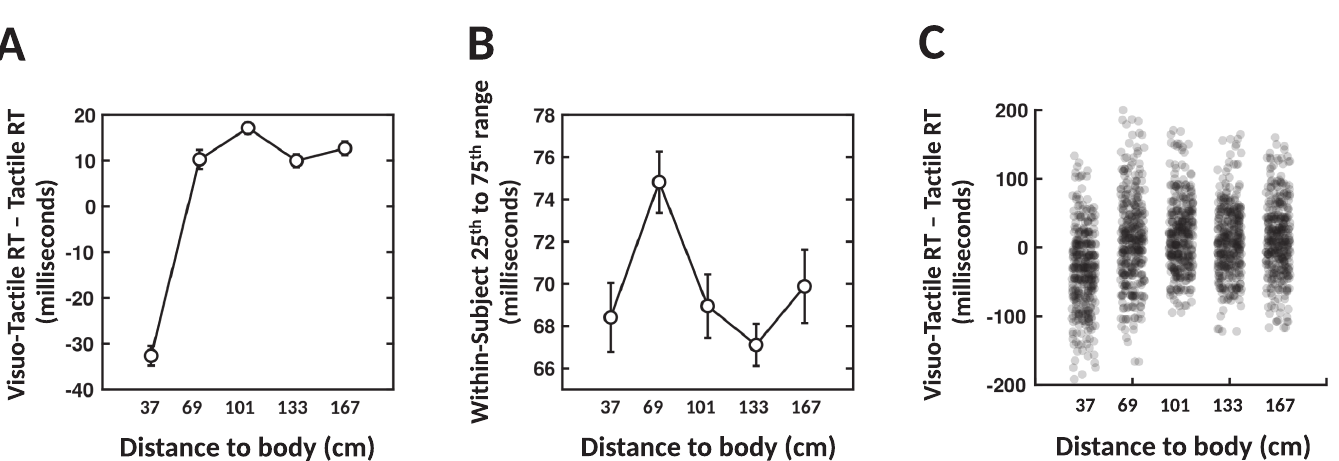
Fig 3. Variability in multisensory facilitation as a function of distance from the self–empirical data. New evaluation of data from Masson et al. [39]. (A) Visuo-tactile facilitation of reaction times (RT) as a function of distance to the body—means and standard errors across subjects. (B) Within-subject variability of reaction times. (C) Aggregate subject, combining visuo-tactile RT facilitation across all